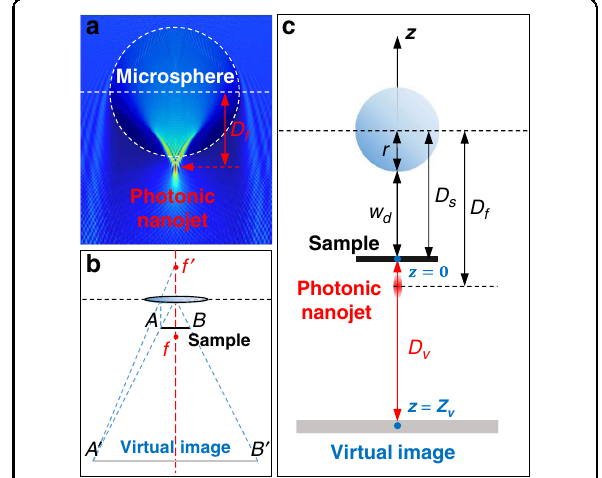
Fig. 2 Formation of the virtual image and relationship between the photonic nanojet and the projected virtual image plane. a Simulated photonic nanojet effect (indicated by the red arrow) by fi nite-difference time-domain (FDTD) method. b Diagram combining ray optics and FDTD simulation. ( AB : sample. A 0 B 0 : virtual image. f : photonic nanojet as a front focal point from FDTD. f 0 : back focal point. T : microsphere regarded as a thin lens.). c Geometric relationship between the microsphere, sample, and virtual image. D v : distance between the virtual image plane and sample. ð D v > 0 Þ D s : distance between the center of the microsphere and sample. ð D s > 0 Þ D f : distance between the microsphere and photonic nanojet, obtained by FDTD simulation. ð D f > 0 Þ w d : distance between the bottom of the microsphere and sample. r : radius of the microsphere. ( w d (cid:2) 0). Z v : axial position of virtual image. ð Z v ¼ 0 (cid:3) D v Þ